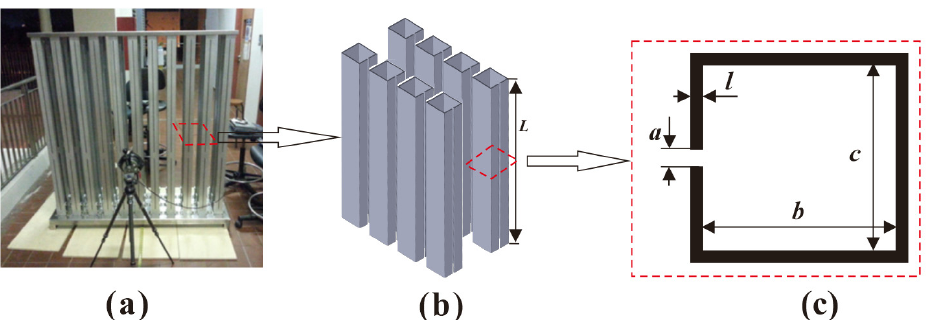
Figure 1. Illustrations of ( a ) a prototype of LRSCs window; ( b ) array of Helmholtz resonators (4 columns); ( c ) geometries of a rectangular Helmholtz resonator.